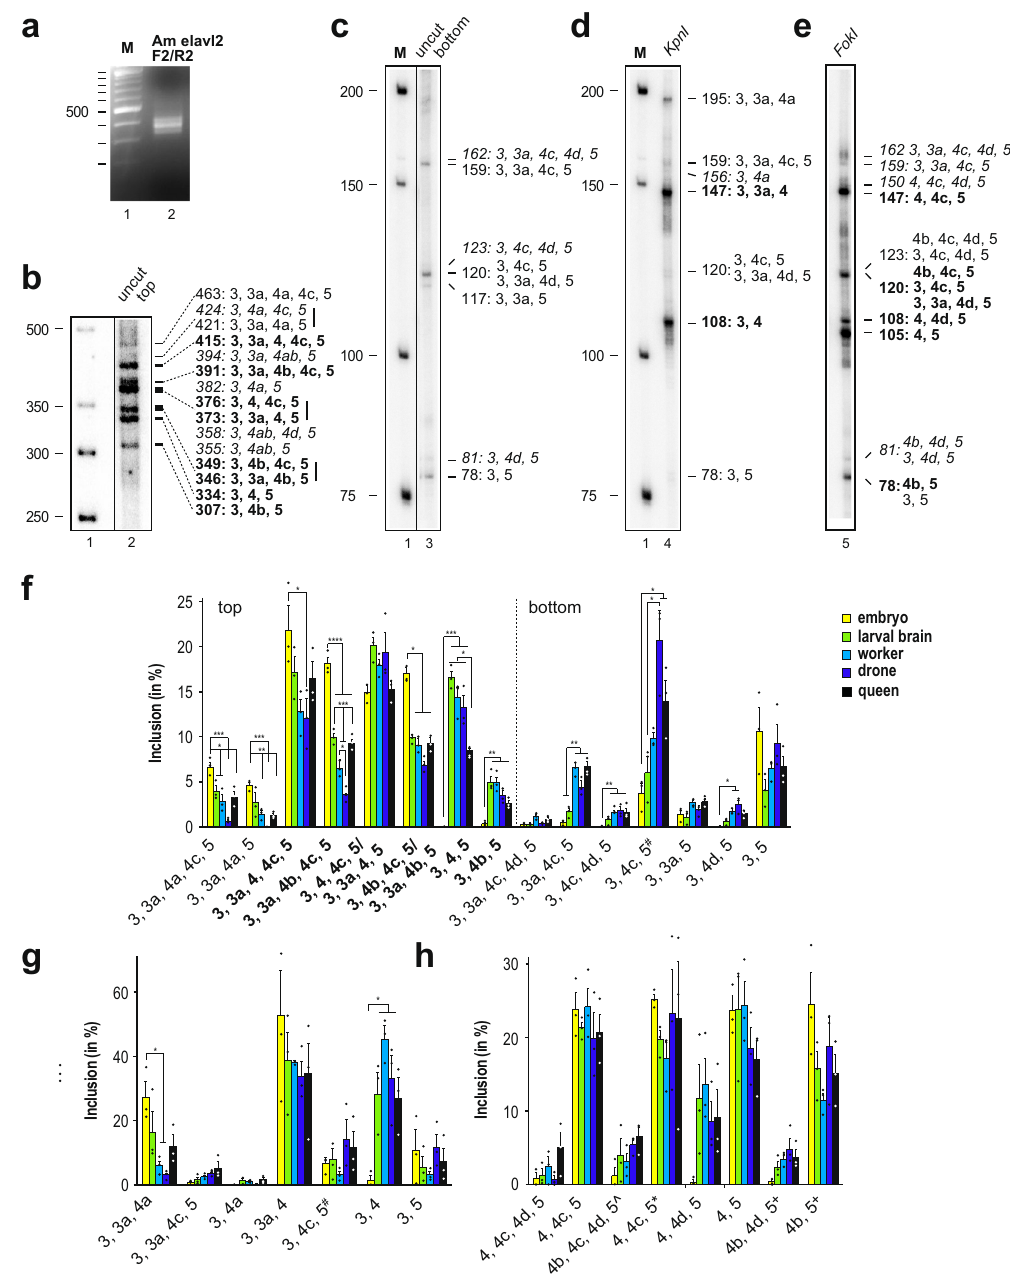
Fig. 3 elavl2 alternative splicing is dynamic during development. a Multiple products are detected from RT-PCR of RNA from larval brain in the alternatively spliced part of bee elavl2 on an agarose gel. M: Marker b , c Top and bottom part of a representative 5% denaturing polyacrylamide gel separating 32 P-labeled alternative splice products from larval brains. Length of PCR products from splice variants are indicated at the right in bold for prominent products and in italics for very rare products. Vertical lines at the right of indicated splice variants indicate inseparable products. M: Marker. d , e Analysis of alternative splicing from larval brains proximal ( Kpn I) and distal ( Fok I) of exon 4 from 32 P-labeled labeled forward ( d ) or return ( e ) primer after digestion with either Kpn I or Fok I on a representative 5% denaturing polyacrylamide gels. Length of PCR products from splice variants are indicated at the right in bold for prominent products and in italics for very rare products. M: Marker. f – h Developmental and sex-speci fi c alternative splicing of bee elavl2 quanti fi ed from denaturing polyacrylamide gels shown as mean with the standard error from three independent replicates as percent from all splice products from top ( f left) and bottom ( f right) gel parts and after Kpn I or Fok I digestion as above from embryos (yellow), larval brains (green), drone brains (light blue), worker brains (dark blue) and queen brains (black). ( f and g ). # The 120 nt product can be either 3, 4c, 5 or 3, 3a, 4d, 5. ( h ) ^The 123 nt products are either 4b, 4c, 4d, 5 or 3, 4c, 4d, 5. *The 120 nt products are either 4b, 4c, 5 or 3, 4c, 5 or 3, 3a, 4d, 5. + The 80 nt products are either 4b, 5 or 3, 5 + / − 4d. The source data underlying this fi gure are available in Supplementary Data